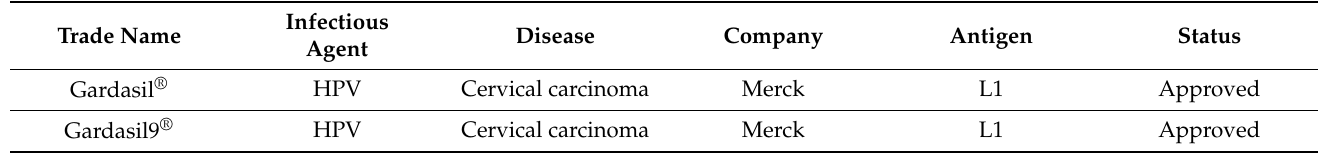
Table 6. VLP-based vaccines expressed in yeast that are either approved by the FDA for commercial use or are undergoing clinical